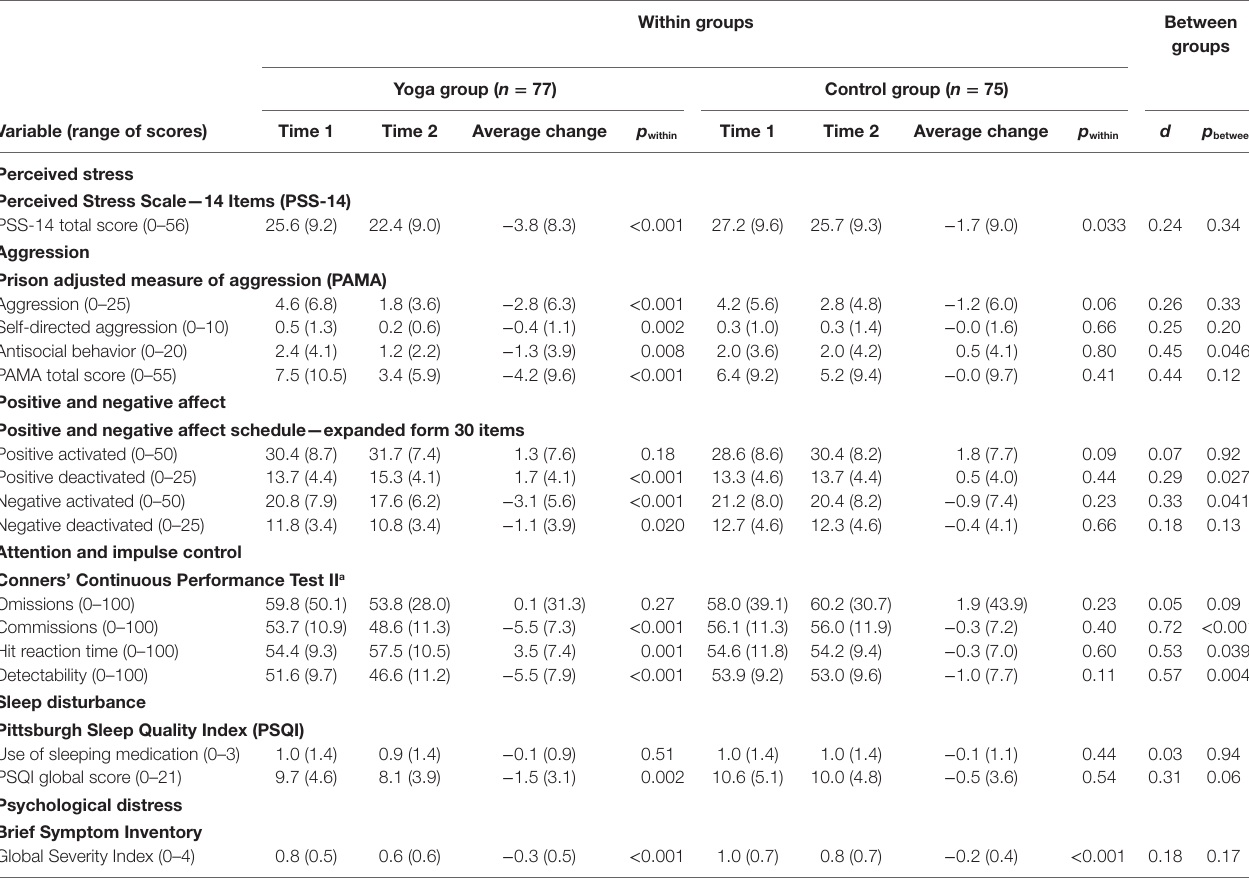
TaBle 3 | Average ratings at pre- and post-intervention assessment (Time 1 and Time 2).